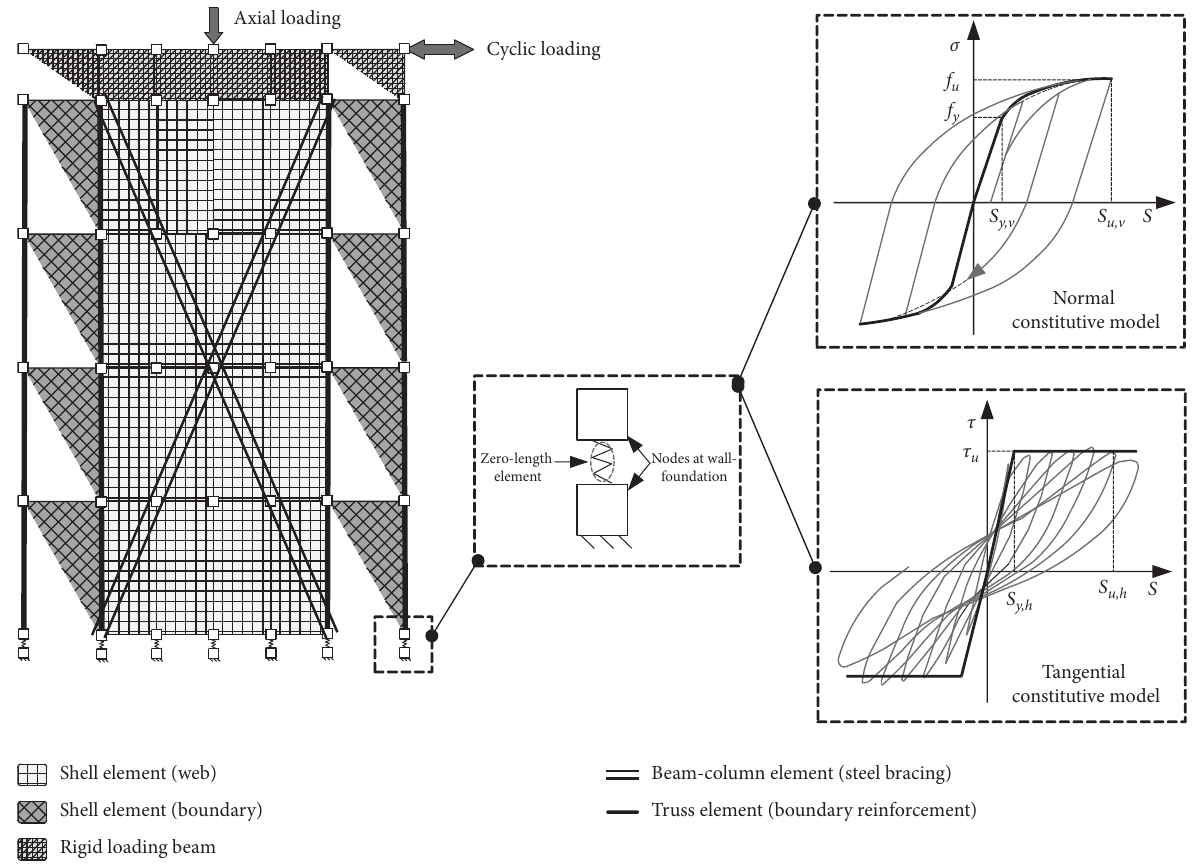
Figure 15: Schematic diagram of the FEA model.